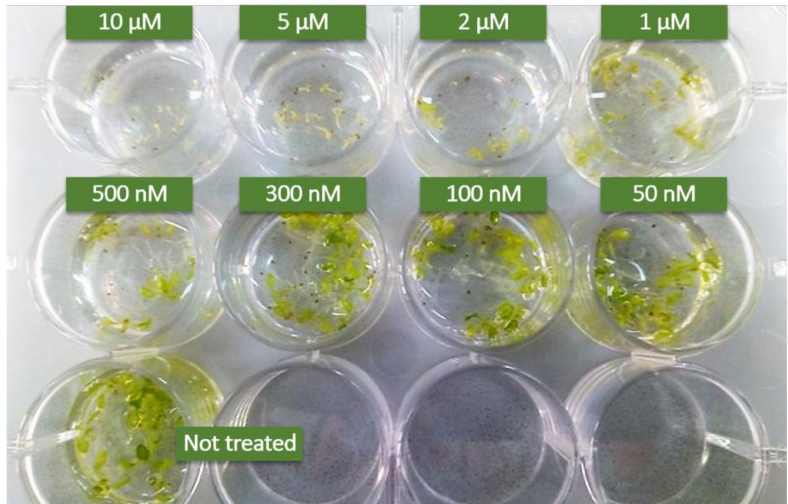
Figure 1. Effects of N B-DNJ-treatment on the Arabidopsis thaliana rsw3 mutant. 15 days-old rsw3 plants grown with different concentration of N B-DNJ. Each well contains about 10 seeds. Above 500 nM, N B-DNJ impairs plant embryo growth. Results derive from three independent experiments ( ± s.e. n = 10).